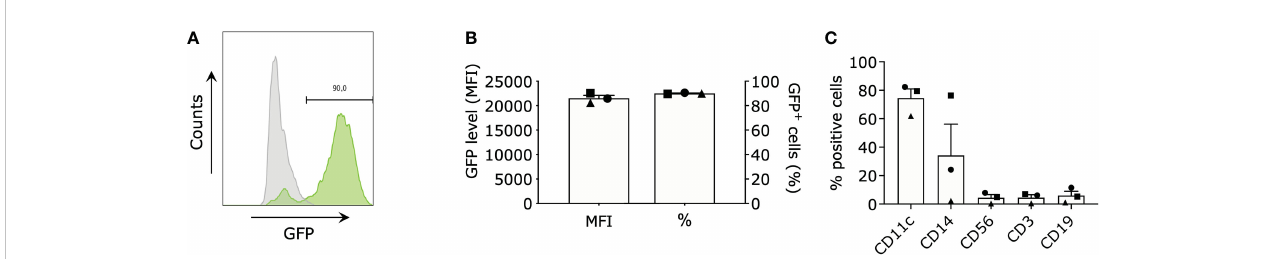
FIGURE 1 Purity and electroporation ef fi ciency of monocyte-derived dendritic cells (moDCs). moDCs were electroporated with green fl uorescent protein (GFP) mRNA (control), TriMix mRNA, or TetraMix mRNA to evaluate the reprogrammable capacities of TetraMix mRNA. (A) Histogram showing the shift of GFP + cells (green) after electroporation (representative data). (B) The two bar graphs illustrate the expression of GFP in moDCs electroporated with GFP mRNA, for three different donors. More speci fi cally, the graphs represent the percentage of GFP-positive cells (right bar) and the geometric mean fl uorescence intensity of GFP (left bar), 24 hours post-electroporation. (C) The bar graph shows the expression of the cell surface markers: CD11c, CD14, CD56, CD3 and CD19 on the moDCs of three different donors, (percentage of positive cells). The bar graphs in (B, C) show the mean value ± standard error of the mean for three independent experiments (n=3). Each symbol represents the data of an individual